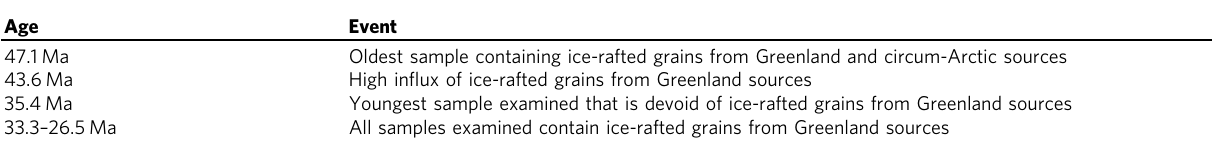
Table 1 Key events in Site 913 records from ~47 – 26 Ma Age Event 47.1 Ma